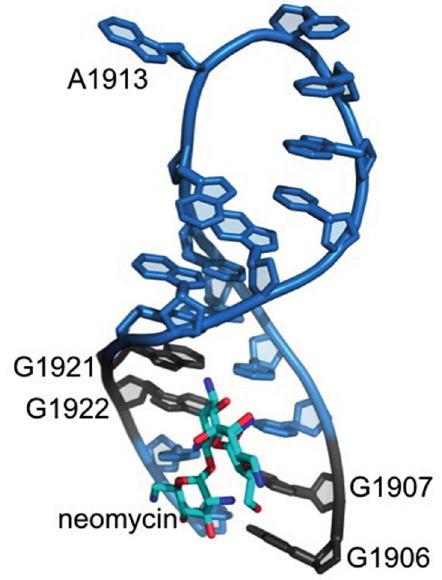
Figure 7. The interactions of H69 with neomycin are shown. Neomycin (cyan) interacts through H69 residues G1906, G1921, and G1922. Residue A1913 is flipped out from the loop. The residues that coordinate to cisplatin are shown in grey and the remaining residues are in blue. The figure was created by using PDB file 4GAQ